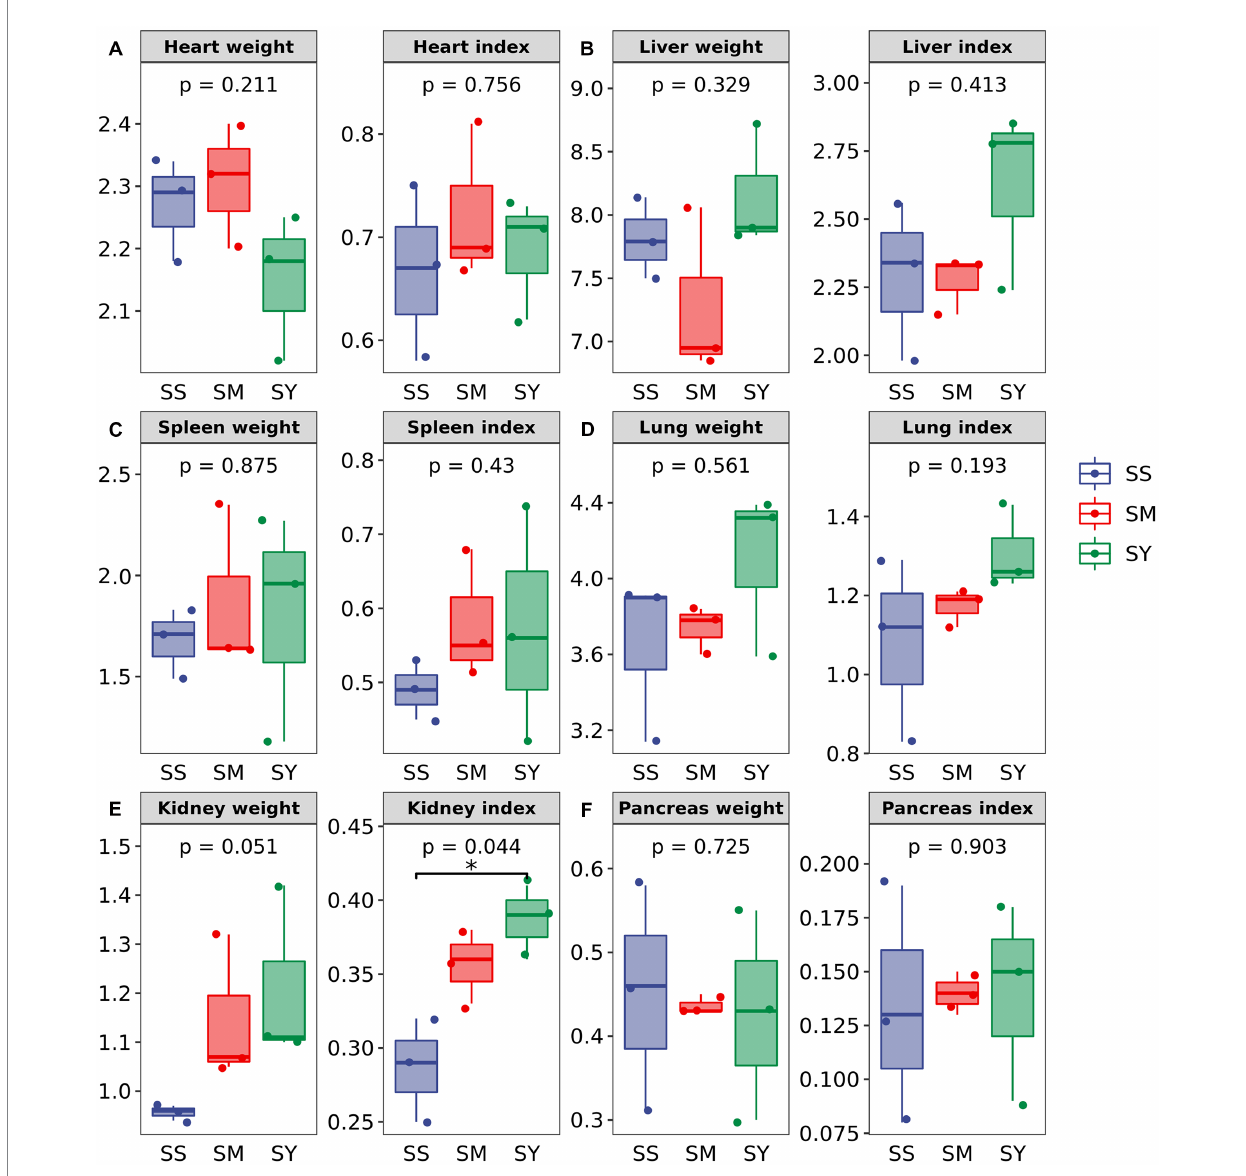
FIGURE 1 Effects of different Se sources on the organ weight and organ index of beef cattle ( n = 3). (A) Heart; (B) Liver (C) Spleen; (D) Lung; (E) Kidney; (F) Pancreas. * p < 0.05; ** p < 0.01. SS, diet supplemented with 0.1 mg Se/kg DM from sodium selenite; SM, diet supplemented 0.1 mg Se/kg DM from selenomethionine; SY, diet supplemented with 0.1 mg Se/kg DM from Se-enriched yeast.